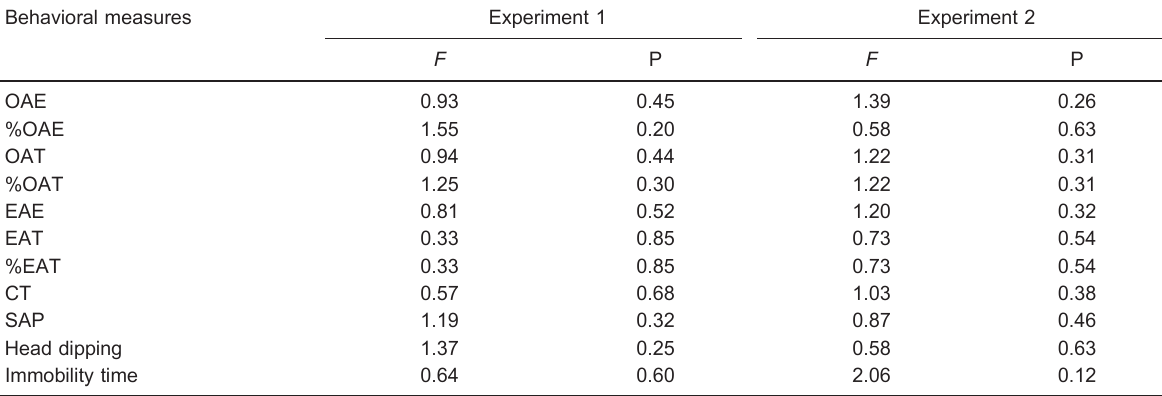
determined that animals explored the open arms for a Figure 2B shows %OAT for the first and second shorter time in the second trial when they had been sessions. ANOVA detected differences in %OAT between microinjected with SAL or CPA (0.016, 0.052, and Table 1. One-way ANOVA statistical results for the behavior of mice with no pharmacological treatment in Trial 1. Behavioral measures Experiment 1 Experiment 2